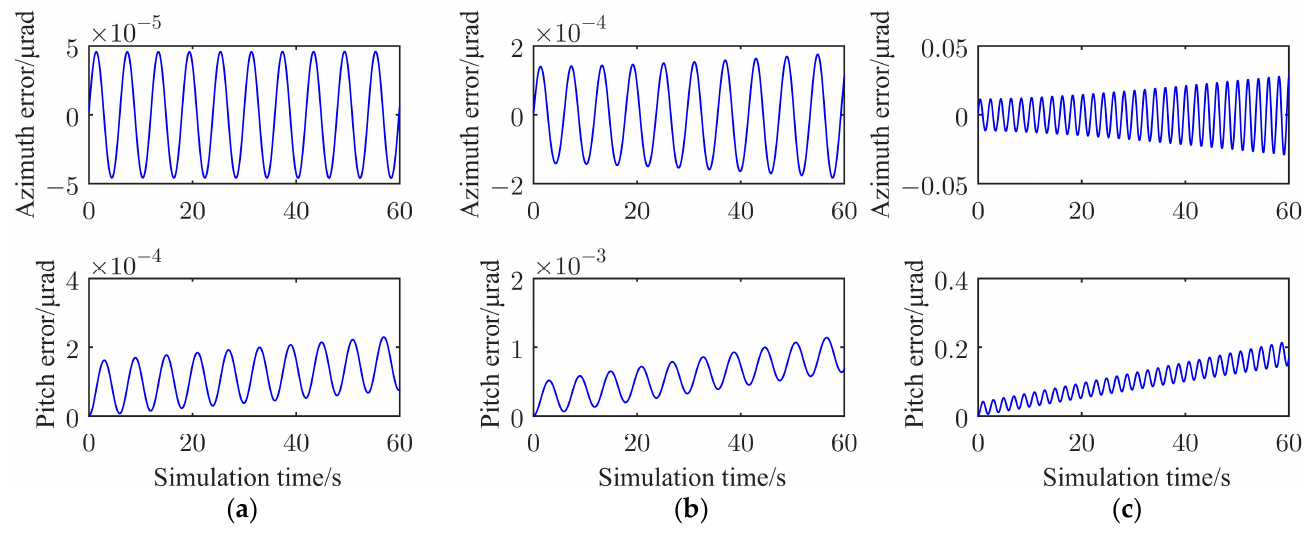
Figure 17. The LOS a tt itude curves under the condition of conical motion in an ideal state in the